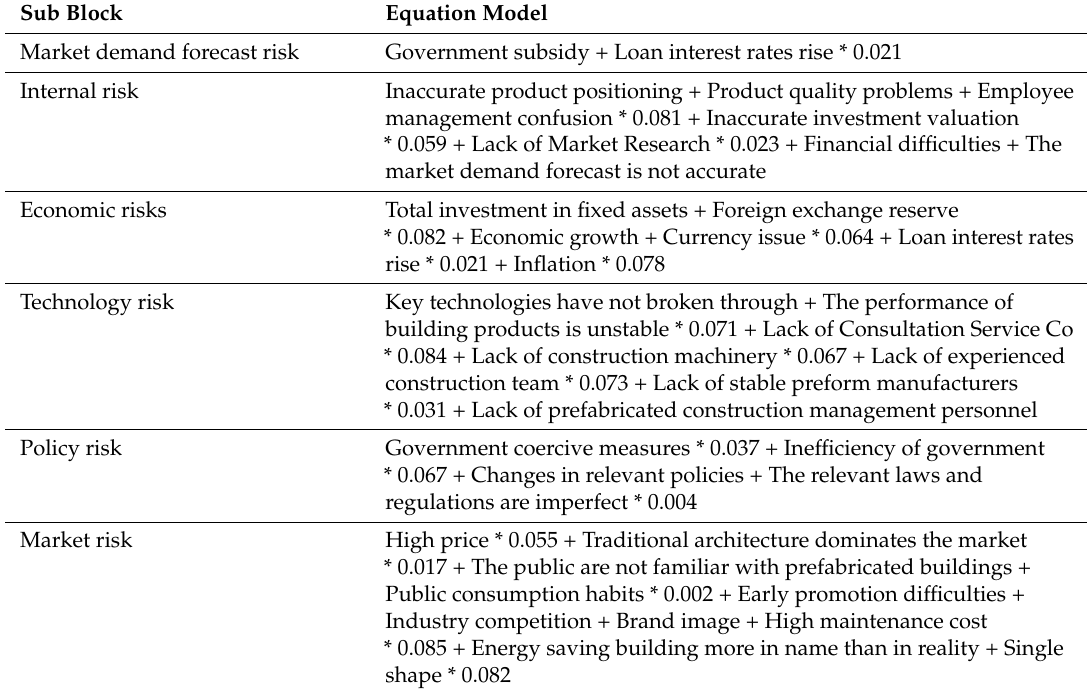
Table 3. Equation model of each